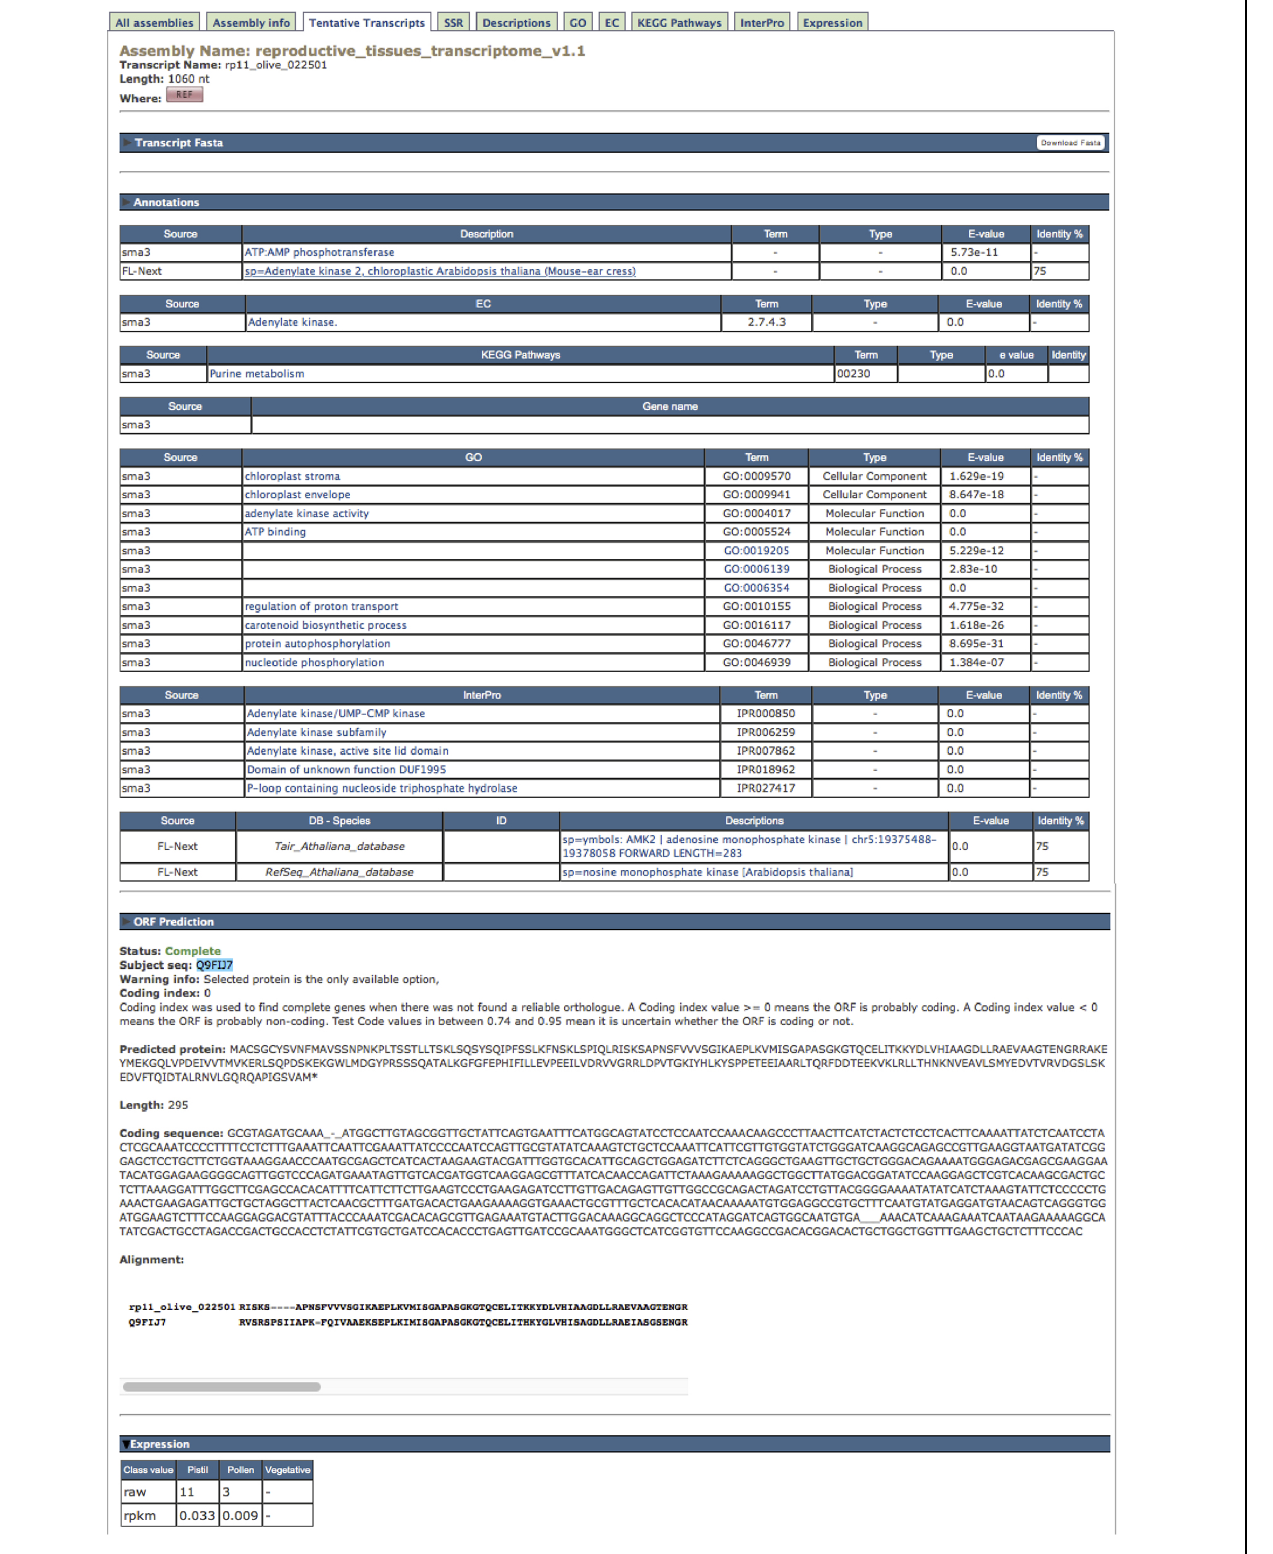
Frontiers in Plant Science |